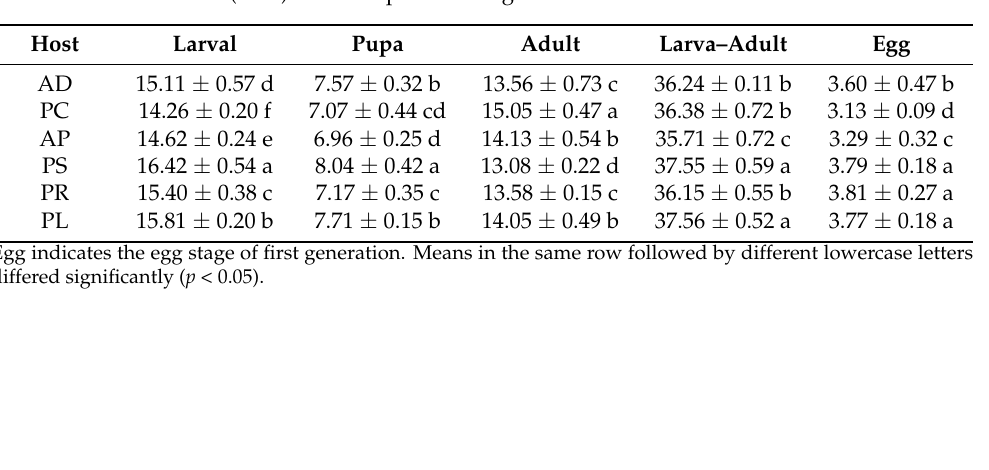
Table 1. Mean duration ( ± SE) of developmental stages of G. molesta fed on different hosts.